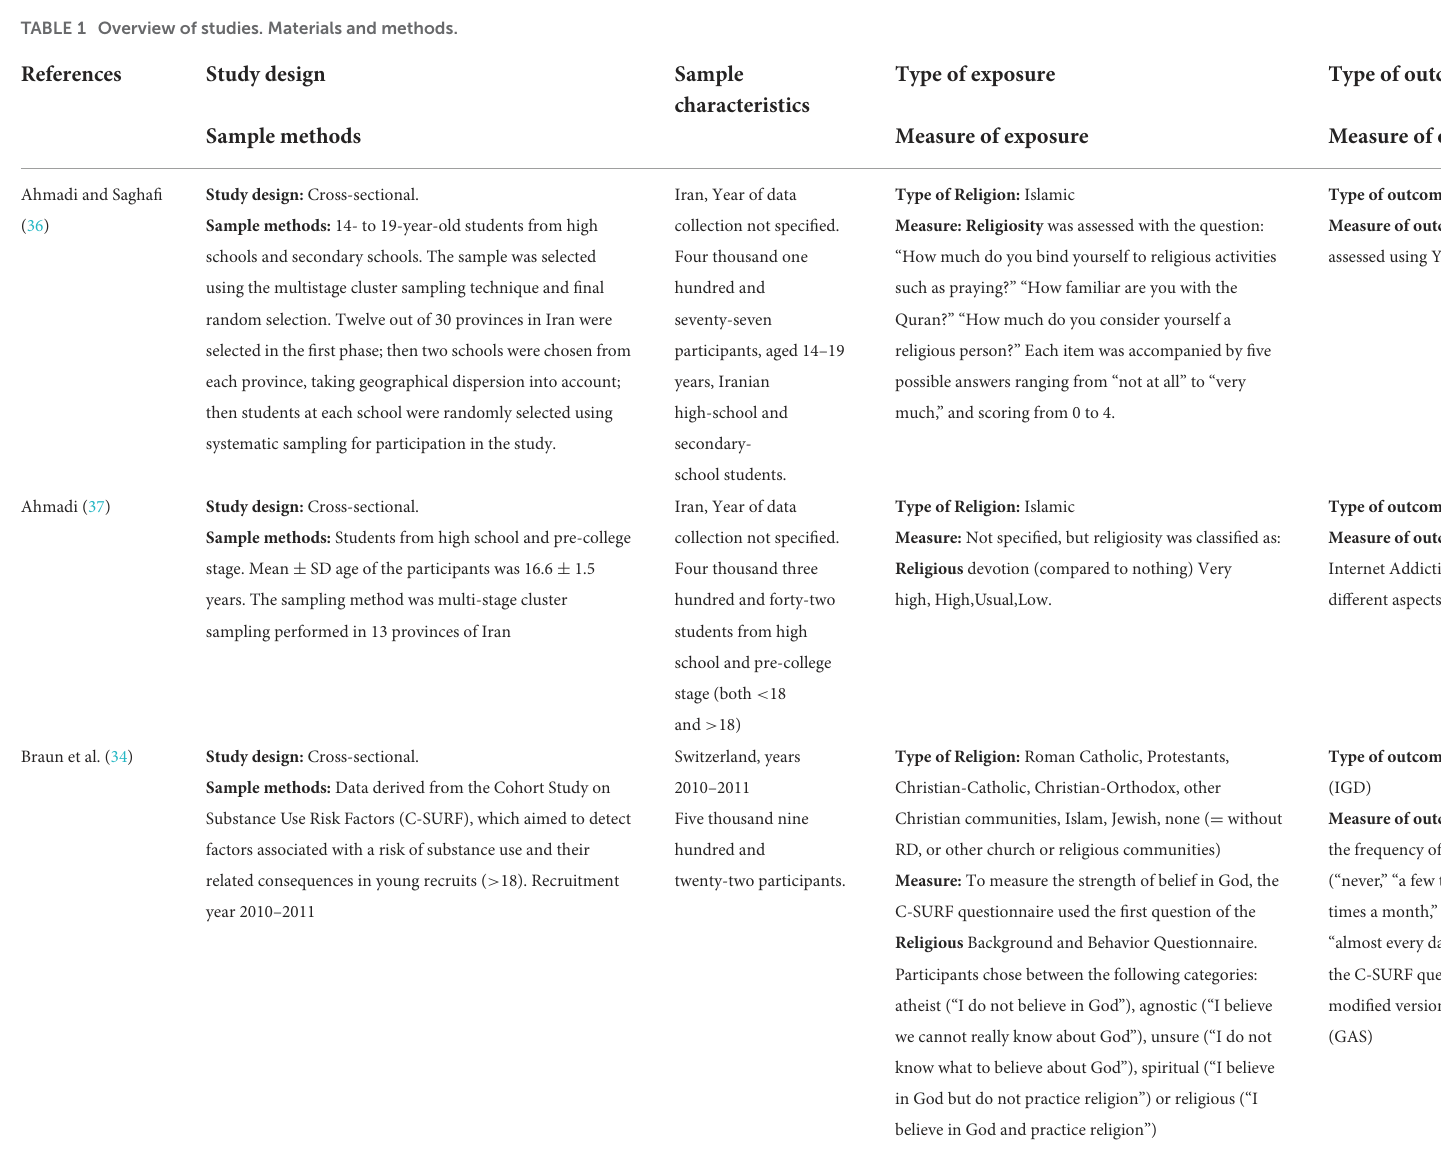
TABLE 1 Overview of studies. Materials and